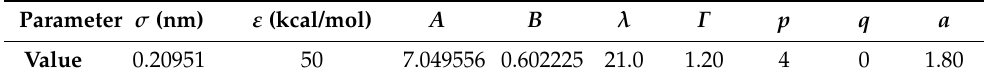
Table 1. The parameter of empirical potential. Parameter σ (nm) ε (kcal/mol) A B λ Γ p a Value 0.20951 1.80